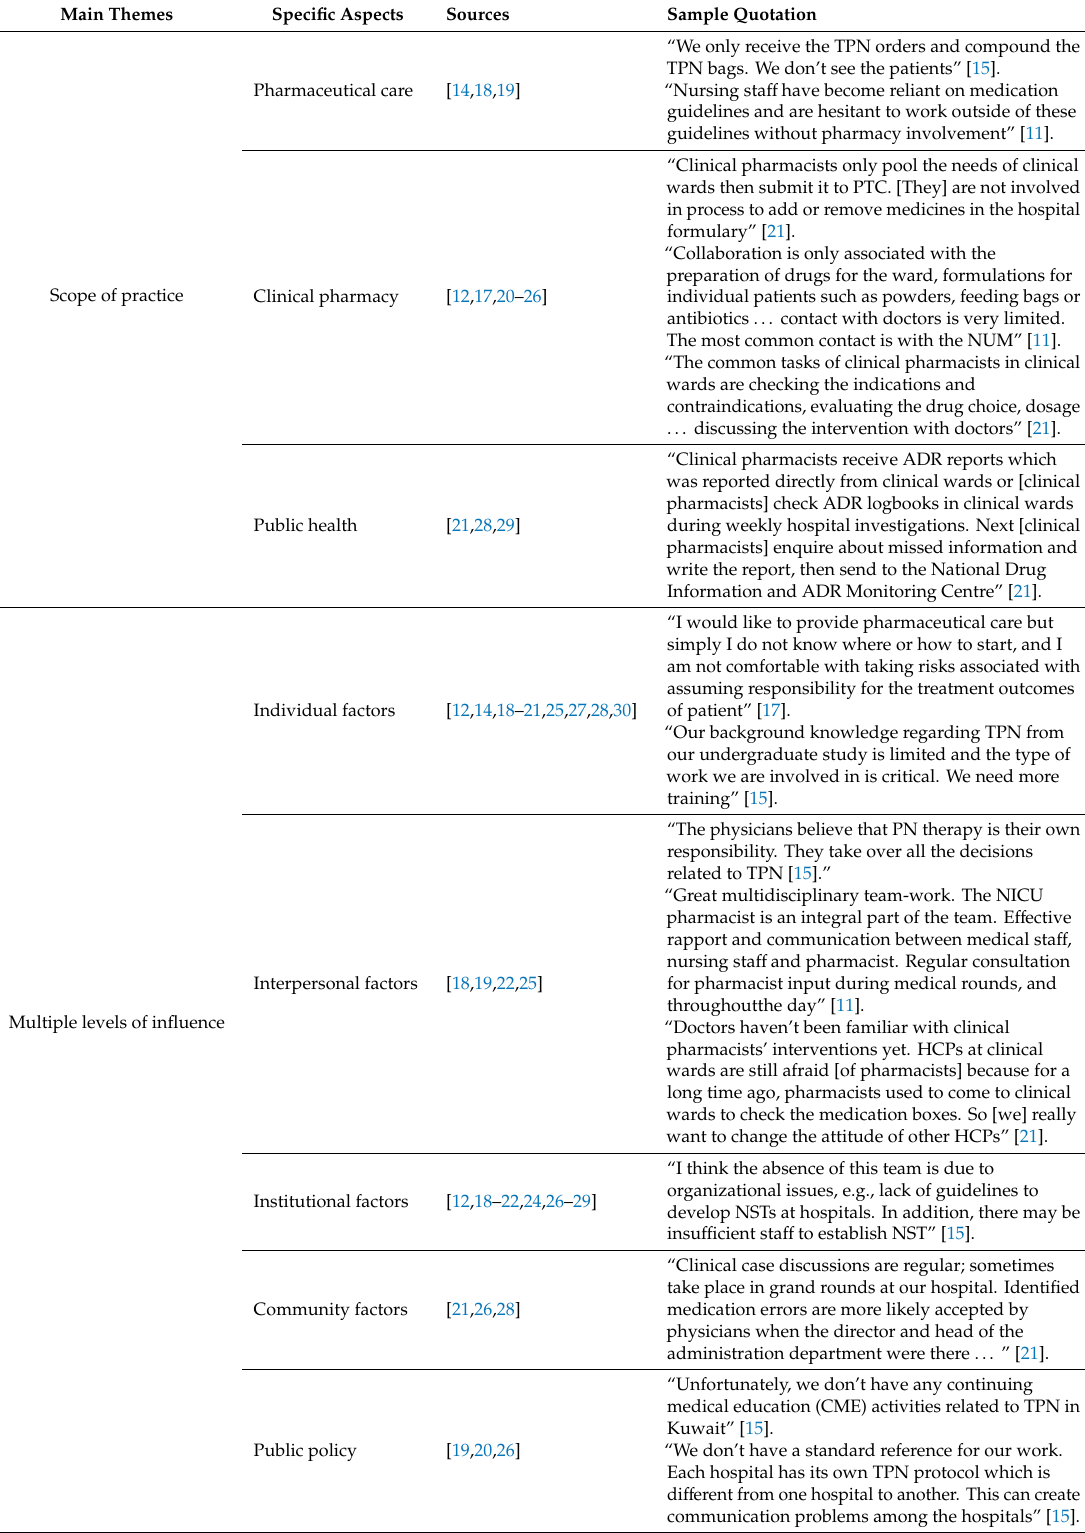
Table 2. Key emerging